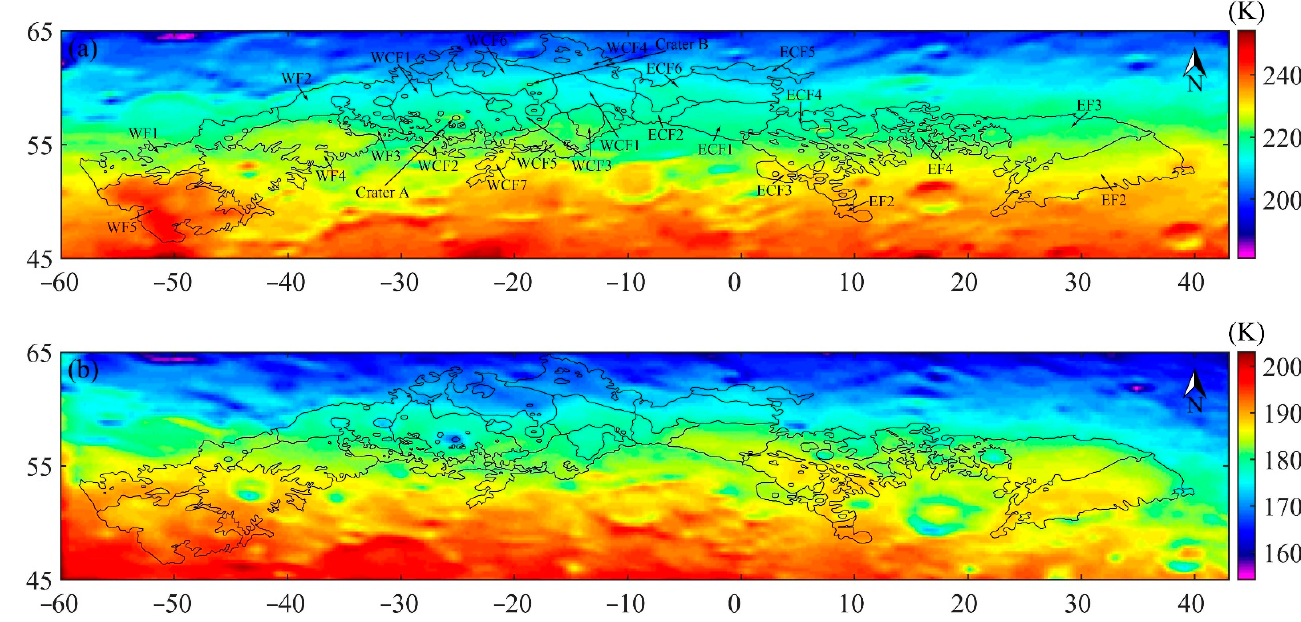
Figure 2. ( a ) The histogram of MRM data points in one lunation (24 h), ( b ) the scatter map of the MRM data points from 12:26 to 13:08, and ( c ) the scatter map of the MRM data points from 0:00 to 0:39 in Mare Frigoris (equidistant cylindrical projection).